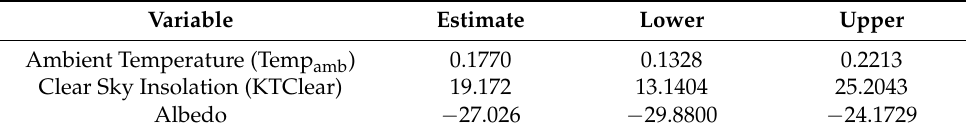
Table 4. Top candidate model parameter estimates and 95% confidence intervals for cow surface temperature (Temp cow ) for white, red, and black Bos taurus cows near Laramie, WY, USA. Variable Estimate Lower Upper Ambient Temperature (Temp amb ) 0.1770 0.1328 0.2213 Clear Sky Insolation (KTClear)